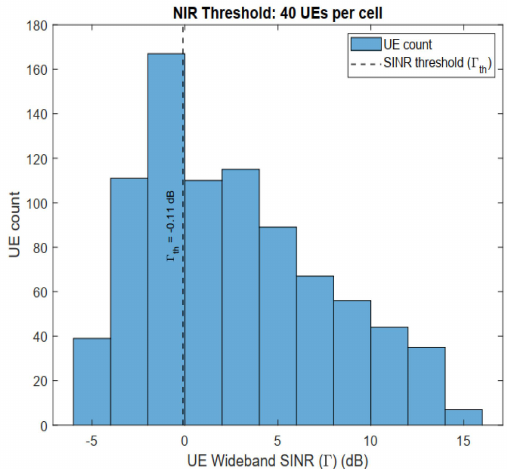
Figure 5. Wideband SINR distribution for 40 UEs.